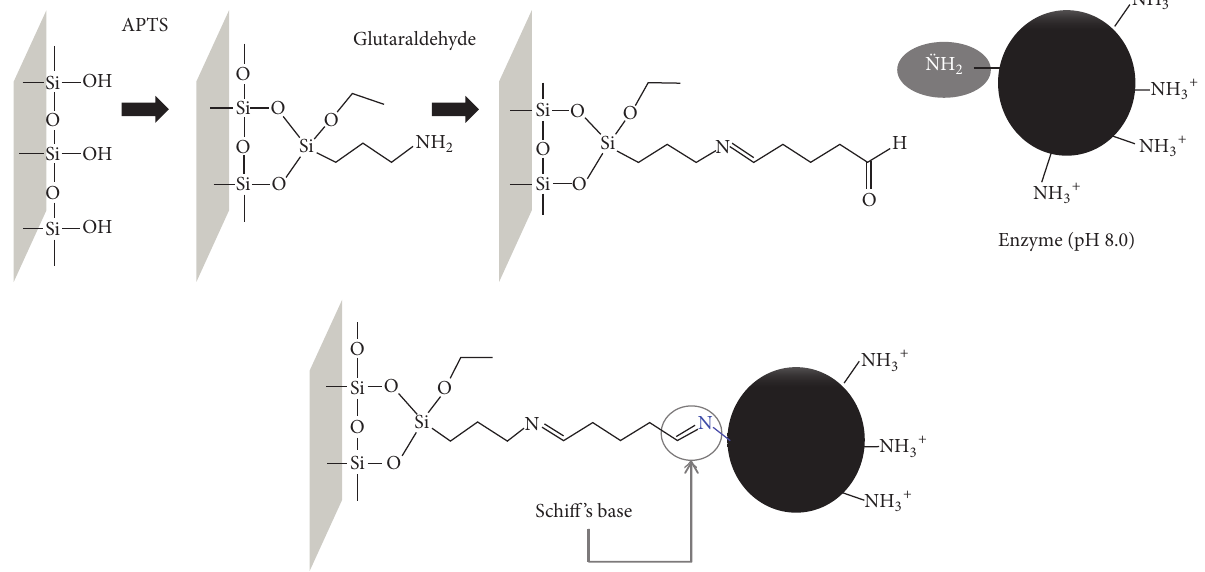
Figure 1: Representative scheme of enzyme immobilization via Schiff’s base formation. Capillary support was activated with 3- aminopropyltrietoxysilane (APTS) and glutaraldehyde, subsequently N-terminal amino group of enzyme binding to aldehyde